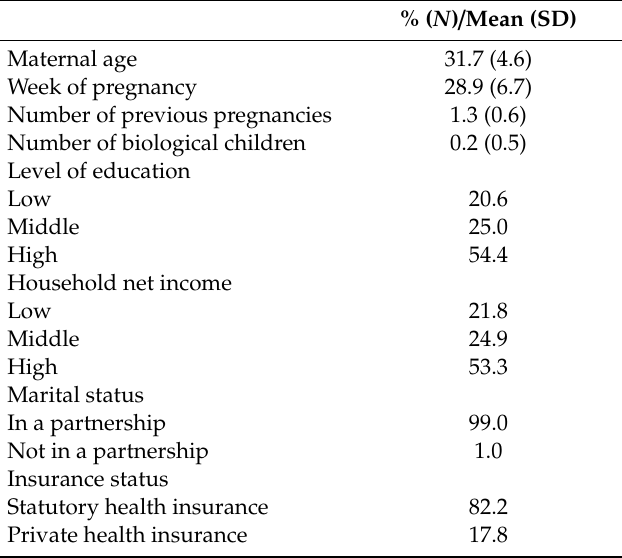
Table 1. Characteristics of the study